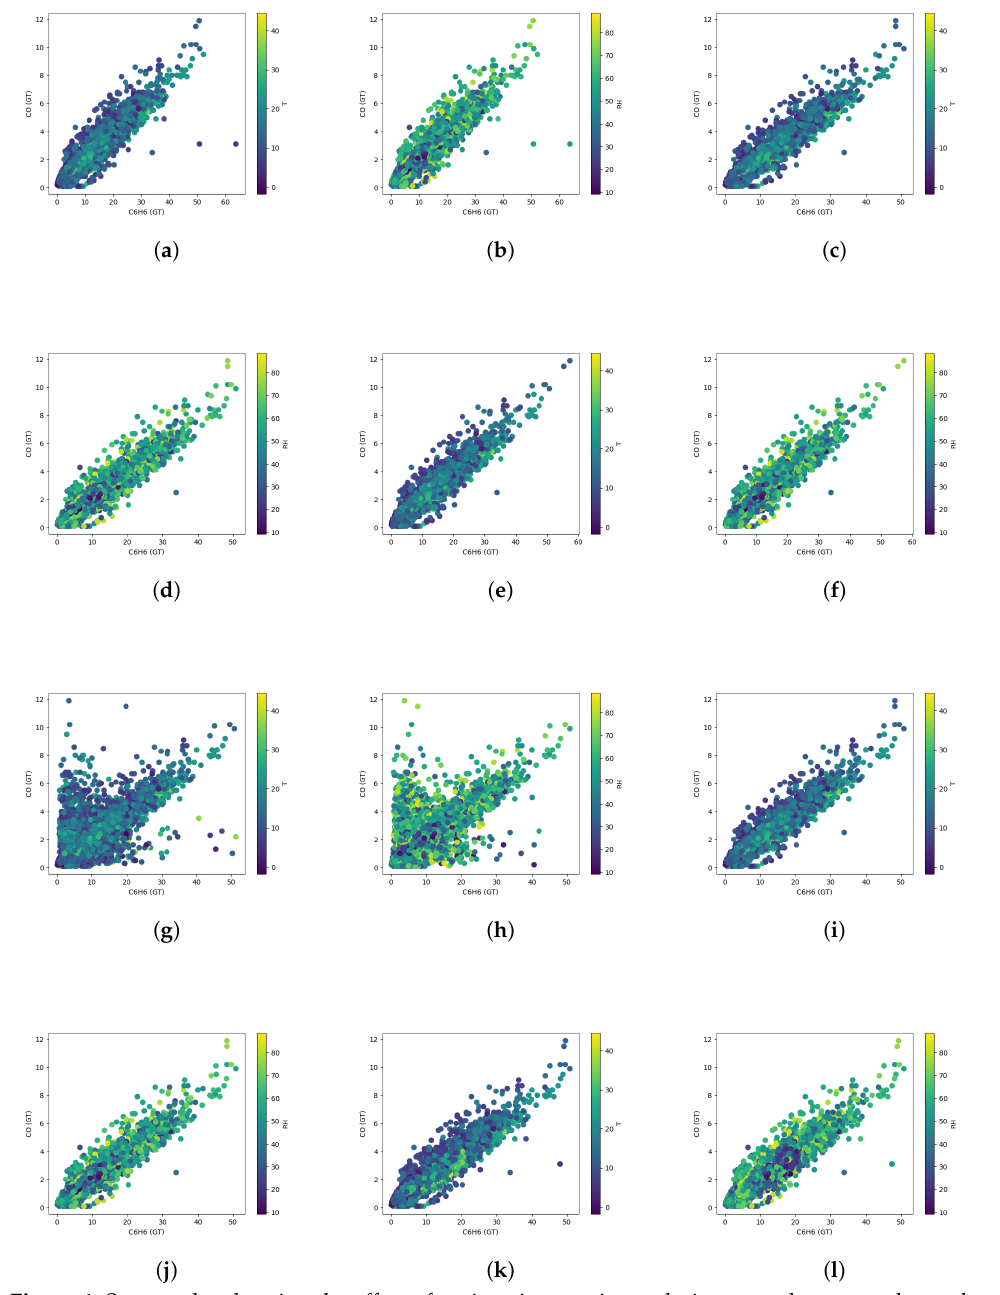
Figure 4. Scatter plot showing the effect of various imputation techniques on the sensor data color- coded with Temperature (T) and Relative Humidity (RH) meteorological factors: ( a , b ) Original data, ( c , d ) k NN Imputation, ( e , f ) Regression Imputation, ( g , h ) EM Imputation, ( i , j ) missForest Imputation and ( k , l )